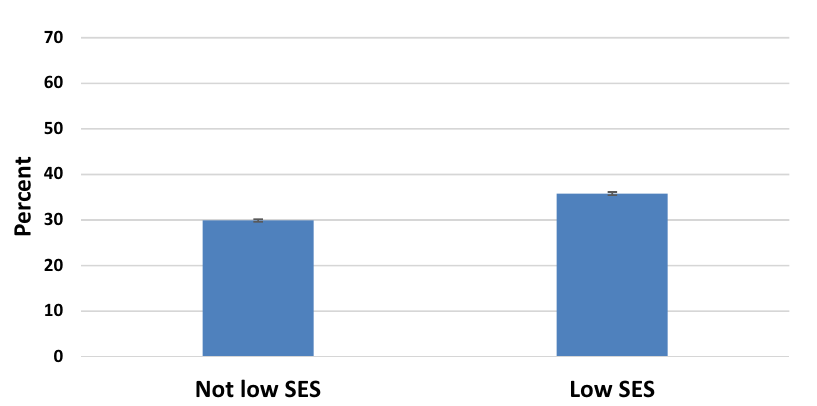
Figure 3. Crude HTN prevalence by SES in All of Us, 2018–2019. Error bars show 95% confidence intervals for HTN prevalence estimates. U.S. Census data is not available for age-distribution by SES categories. Figure was created with Microsoft Excel for Mac, Version